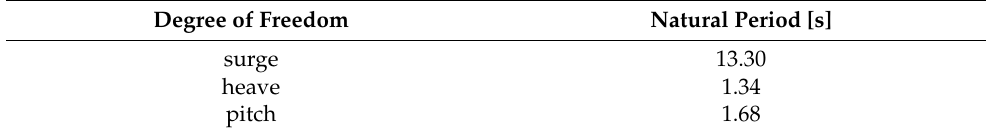
Table 2. Free decay test results.